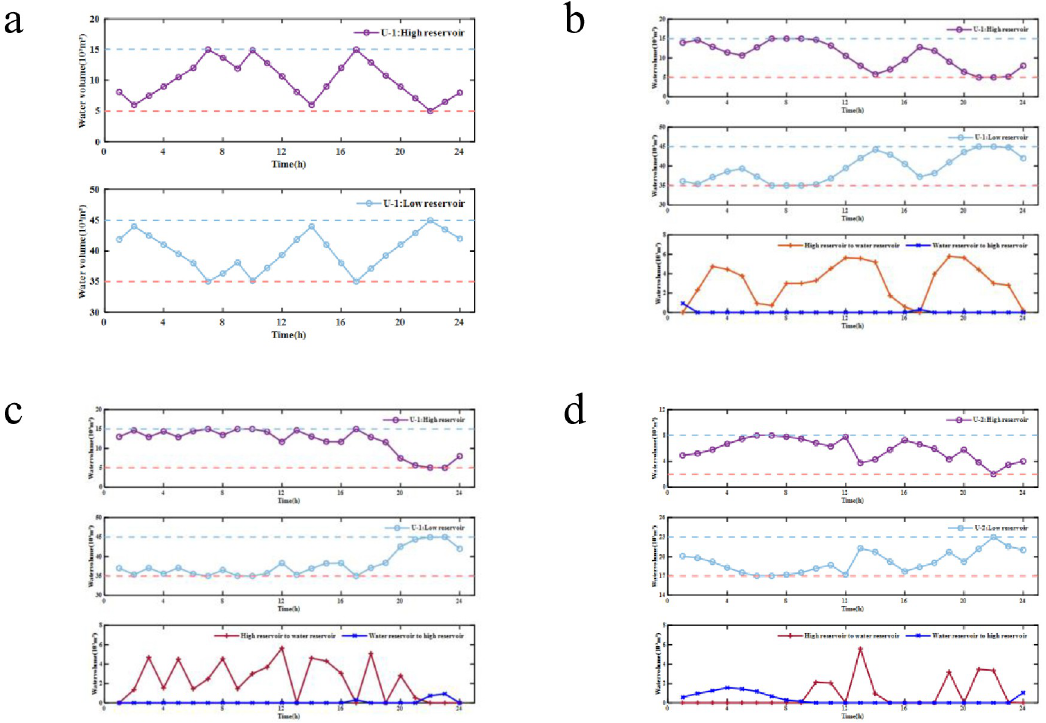
Fig 7. Variation of water volume in the reservoir in Case 2–4: (a) Variation of water volume of U-1 in Case 2, (b) Variation of water volume of U-1 in Case 3, (c) Variation of water volume of U-1 in Case 4, (d) Variation of water volume of U-2 in Case 4.